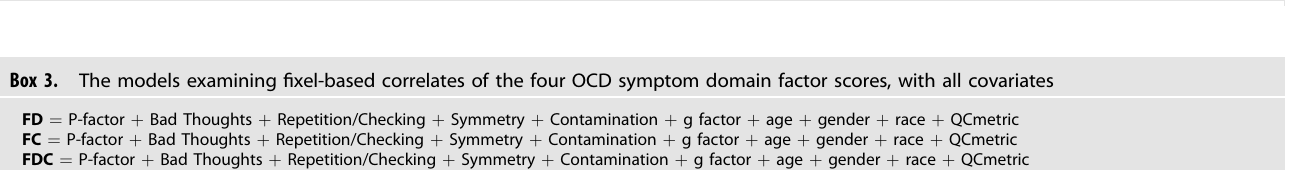
Fig. 2 Fixel correlates of general psychopathology. There was an age-dependent association between p-factor scores and FD in the splenium of the corpus callosum. Panel (A) shows the signi fi cant effect mapped on an axial plane, with the heatmap representing family-wise error corrected p-values ranging from 0.05 to 0.007 (brighter values are more signi fi cant). Panel (B) demonstrates the post-hoc visualization of the interaction effect, with age ranges de fi ned by quartiles. Panel (C) displays a tractogram to further characterize the anatomy of the results; the signi fi cant ROI was used as a seed region and probabilistic tractography was used to construct the tractogram. Box 2. The models examining fi xel-based (FD, FC, and FDC) correlates of OCS factor scores, with all covariates FD = P-factor + OCS factor + g factor + age + gender + race + QCmetric FC = P-factor + OCS factor + g factor + age + gender + race + QCmetric FDC = P-factor + OCS factor + g factor + age + gender + race + QCmetric FD = P-factor + OCS factor + g factor + age + gender + race + QCmetric + (OCS factor × age) FC = P-factor + OCS factor + g factor + age + gender + race + QCmetric + (OCS factor × age) FDC = P-factor + OCS factor + g factor + age + gender + race + QCmetric + (OCS factor × age)